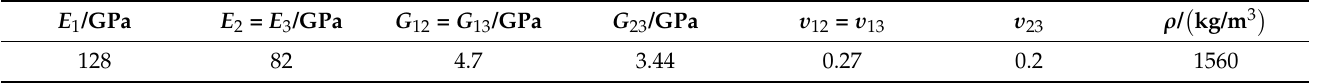
Table 2. Elastic properties of composite plate in the numerical